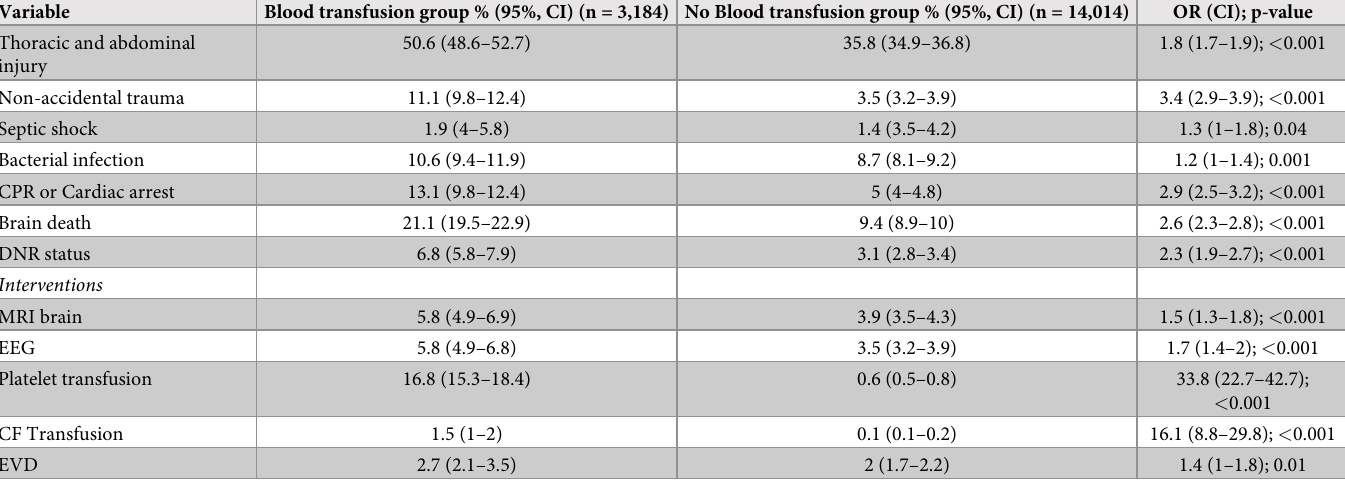
Table 2. Clinical characteristics of children with traumatic brain injury and mechanical ventilation with and without blood transfusion therapy. The values are pre- sented as percentages (95% Confidence intervals).